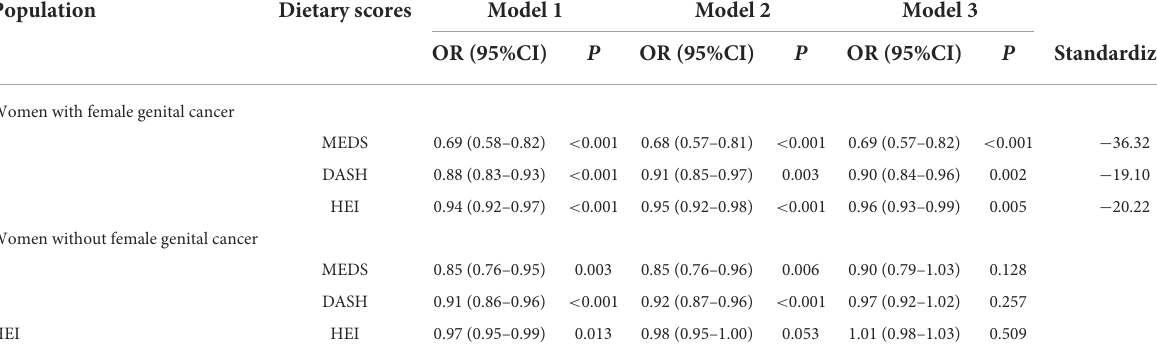
TABLE 5 Association analysis of dietary scores and depression in female genital cancer